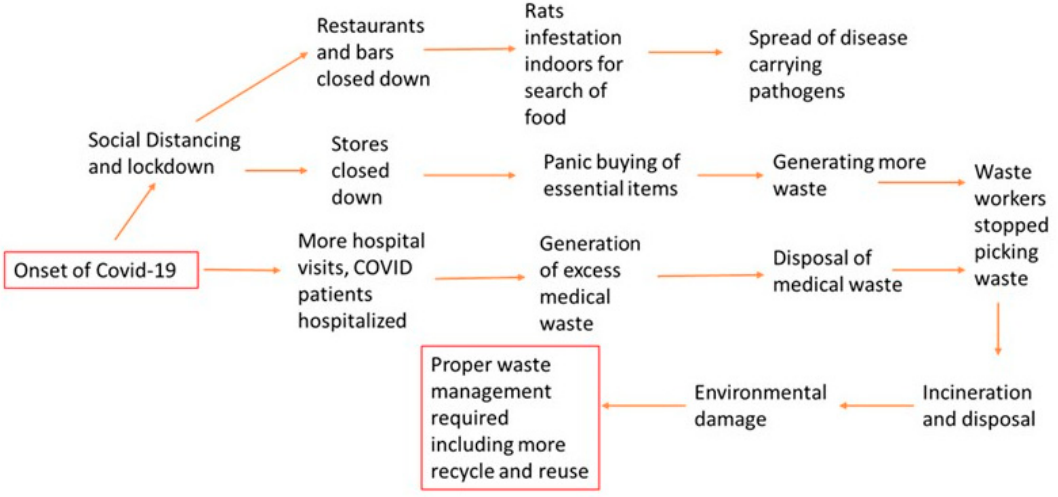
Figure 3. A flowchart showing challenges waste management sectors faced during COVID-19.